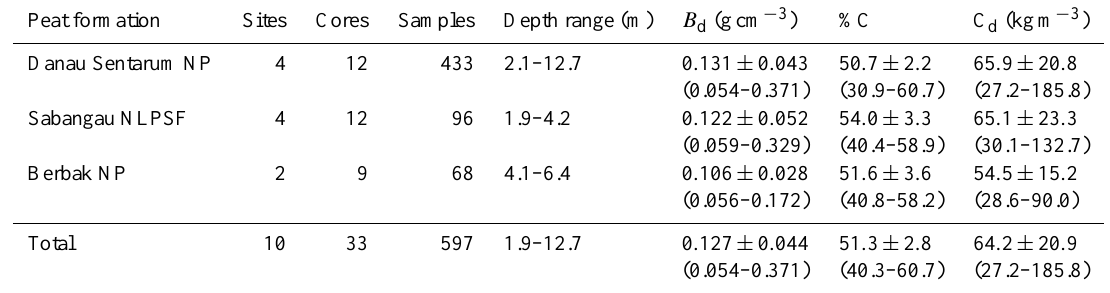
Table 3. Summary statistics of peat samples collected from three Indonesian peat formations and literature values used to develop predictive models for C d . Values for B d , %C and C d are expressed as mean ± SD, and values in parentheses indicate the range of observations.